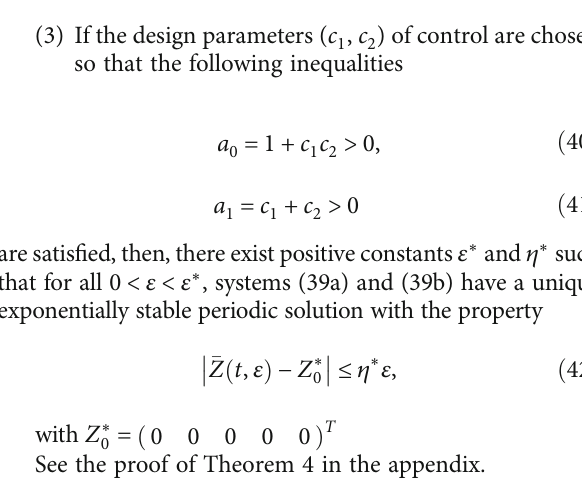
Figure 6: (a) Voltage v at the terminals of sensitive load after compensation. (b) Zoom of this L